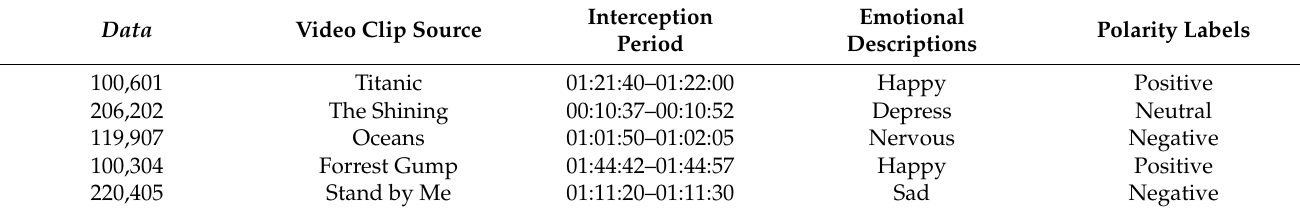
Table 1. Example data from